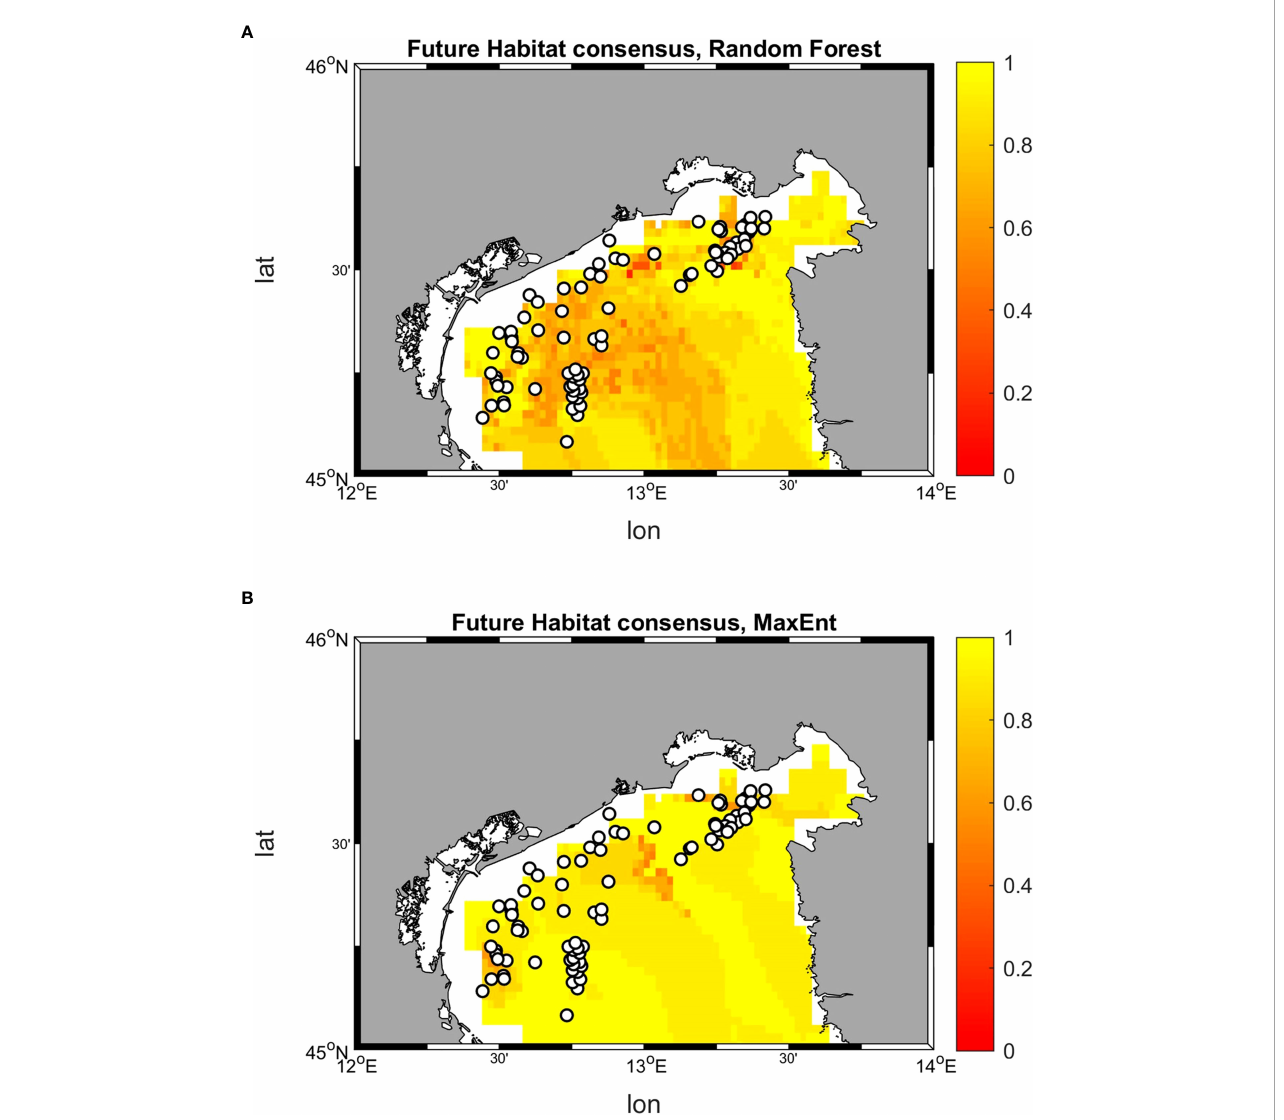
FIGURE 14 Consensus between projected habitat distribution in the sensitivity analysis and the SCE run for Random Forest (A) and MaxEnt (B)